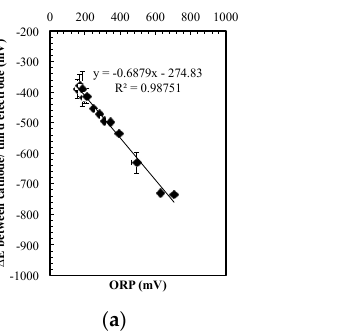
Figure 4. ( a ) The potential on the cathode and the anode versus saturated Ag/AgCl reference electrode at 0.05 μ A, ( b ) 0.15 μ A, and ( c ) 1.0 μ A.